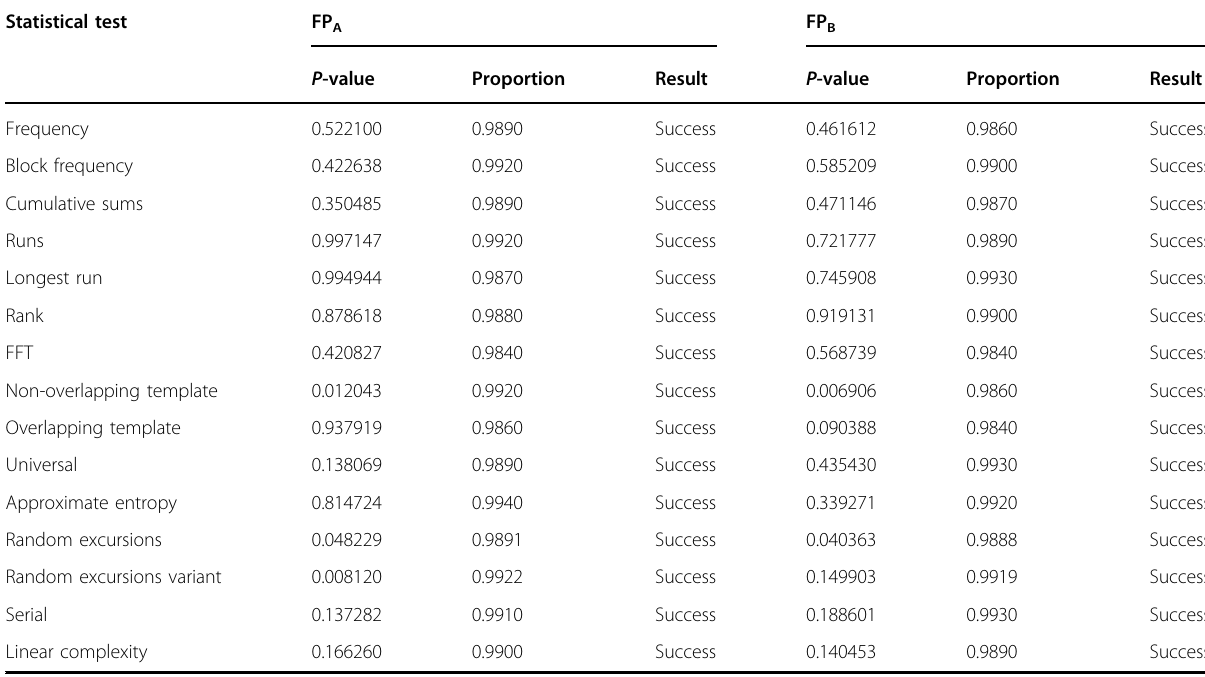
Table 1 Results of NIST test of key sequences generated from two FP lasers. Statistical